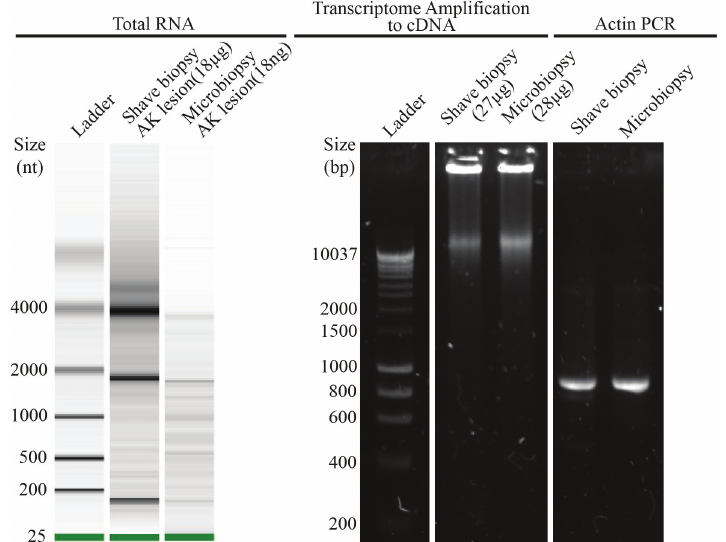
Figure 5. Molecular characterization of conventional shave biopsies and microbiopsies. The left panel shows the Bioanalyzer readout from amplified DNA from a conventional actinic keratosis (AK) shave biopsy next to the microbiopsy DNA sample obtained from the same AK lesion. The middle panel shows the Bioanalyzer readout from RNA isolated from a conventional AK shave biopsy and a microbiopsy that was obtained from the same AK lesion. The right panel compares the RNA quality of a shave biopsy and normal skin microbiopsy that were subjected to total transcriptome amplification to generate cDNA. The cDNA was then used as a template for a PCR reaction containing actin specific primers with an expected product at 800 bp.